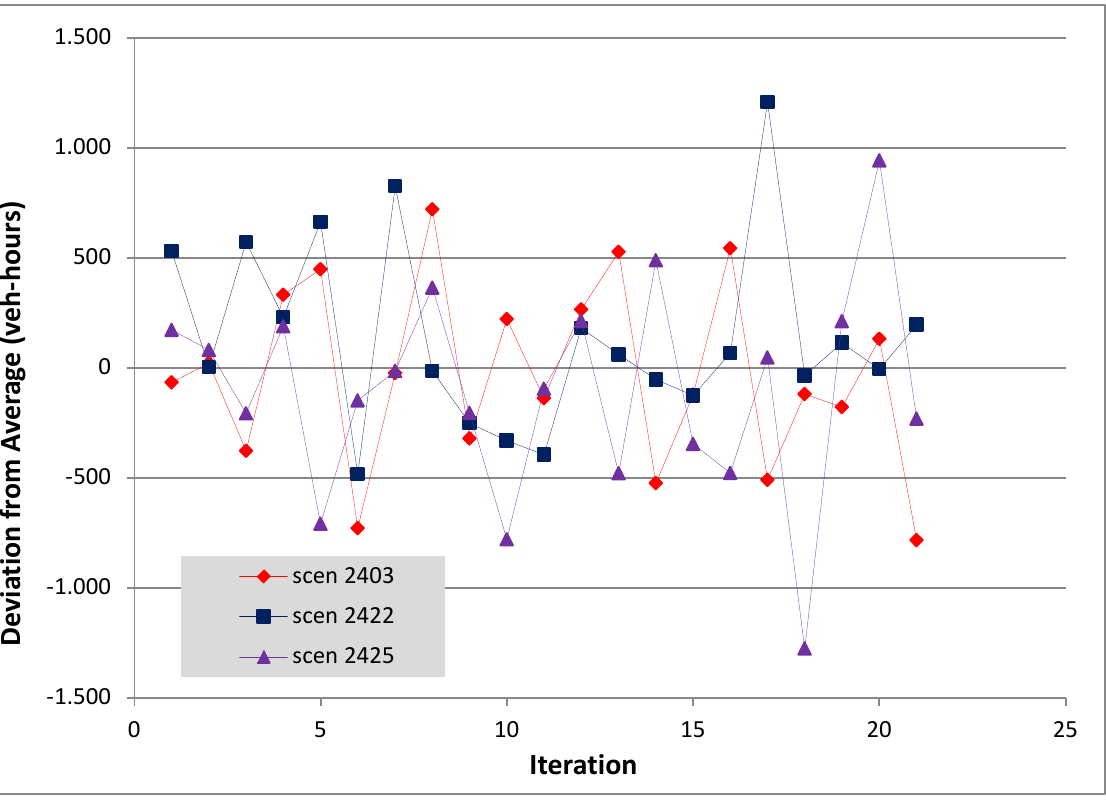
Figure 8. Variations of VHT in ABM